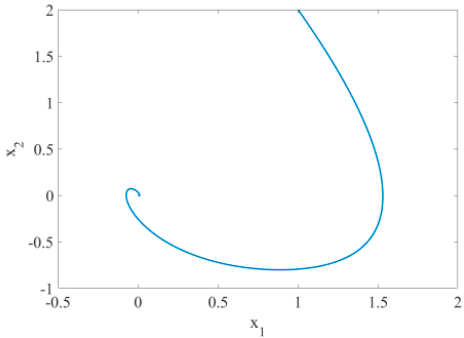
Figure 8. Time response of system with known parameters (with disturbance,